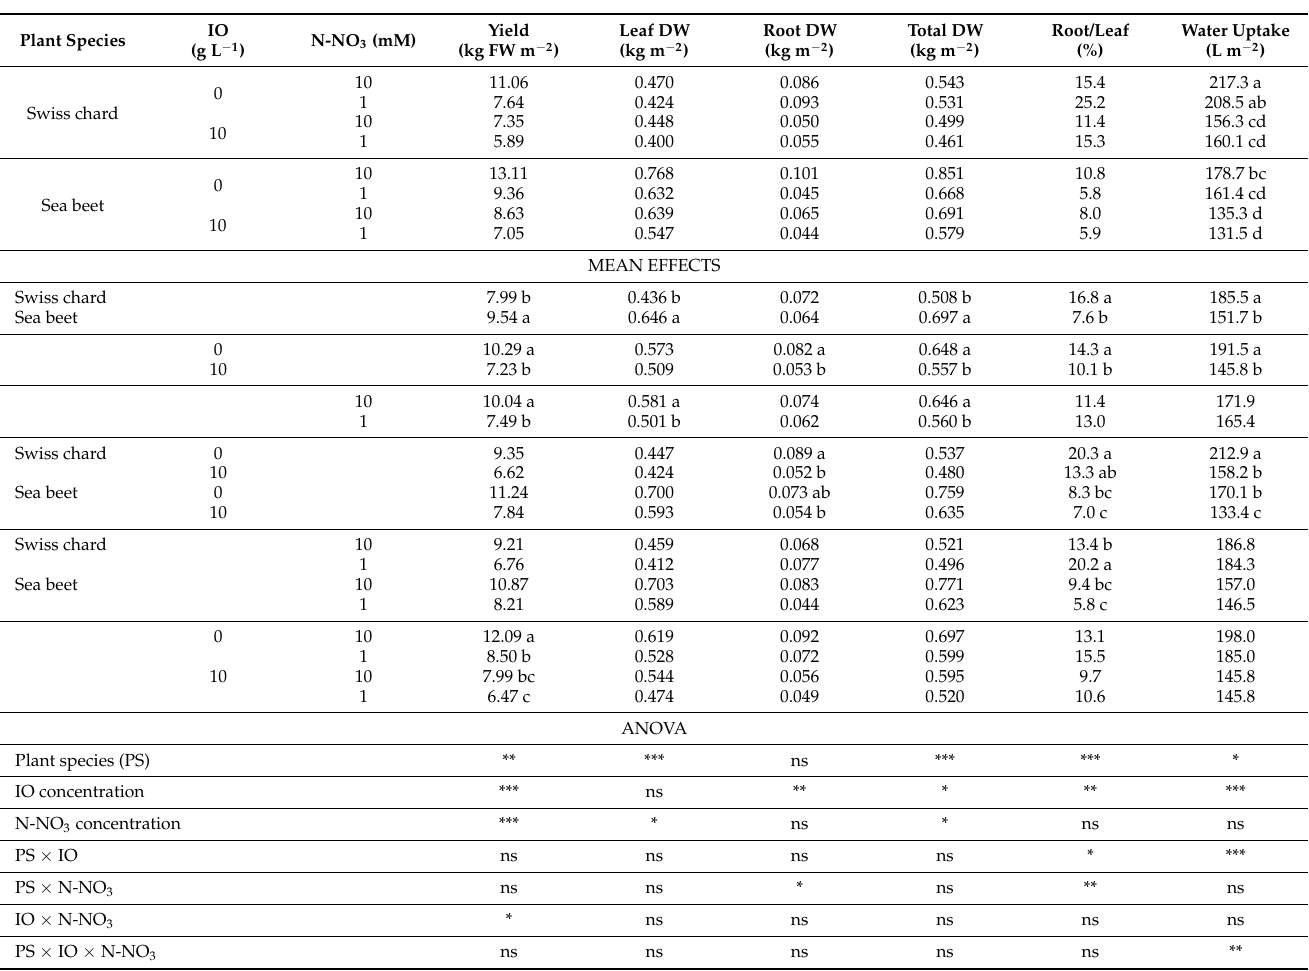
Table 3. Total crop yield (leaf fresh weight, FW) and dry weight (DW) of leaves, roots and whole plants, root/leaf DW ratio, and total uptake of water and nitrogen (N) of Swiss chard and sea beet plants grown hydroponically with different concentrations of the sea salt Instant Ocean (IO; 0 and 10 g L − 1 ) and nitrogen (1 and 10 N-NO 3 mM) in the nutrient solution (see Table 2 for abbreviations). in the nutrient